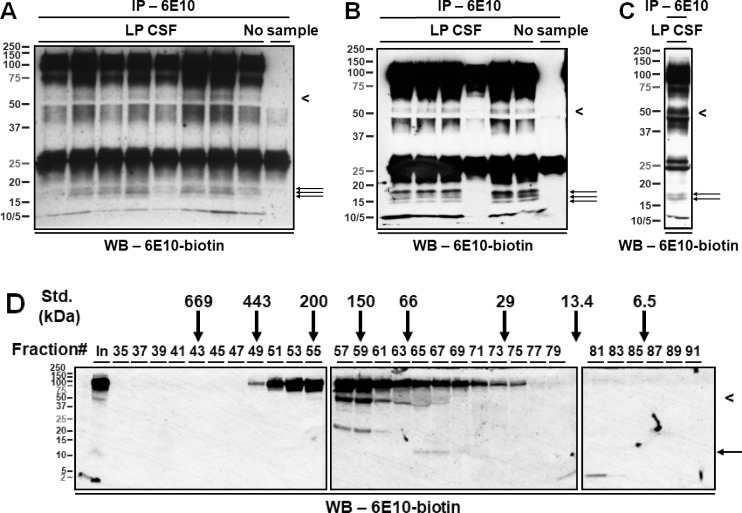
6E10-immunoreactive proteins in human CSF.(A-C) Representative IP/WB. Monoclonal antibody 6E10 was used to immunoprecipitate Aβ/APP metabolites from human CSF samples (250 μL per sample). Immunocaptured proteins were separated by SDS-PAGE, and detected by biotinylated 6E10. Note the proteins migrating at ~55 kDa (arrowhead) and at ~15 kDa (arrows), which are further characterized in this study. Proteins migrating at ~100 kDa and at <10 kDa likely represent the soluble, α-secretase-cleaved APP metabolites (sAPPα) and monomeric canonical Aβ1-40/42, respectively. Proteins migrating at ~70 kDa likely represent APP metabolites whose identities are beyond the scope of investigation of this study. Three sets of samples (A, 250 μL of CSF per lane; B, 240 μL of CSF per lane; C, 160 μL of CSF) were immunoprecipitated by monoclonal antibody 6E10; the eluates were separated by SDS-PAGE using 10.5–14% Tris-HCl gels and detected by biotinylated 6E10. The IP/WB experiments were performed by different experimenters at three different times spanning a five-year period; nonetheless, Fig 2A, 2B and 2C show a similar WB pattern. (D) WB showing fractionation of 6E10-immunoreactive species by SEC. The ~100- and ~70- kDa proteins were eluted together in fractions 49–75, the ~55-kDa proteins in fractions 57–63, the ~15-kDa proteins in fractions 65–69, and the <10-kDa proteins in fractions 79–83. No <10-kDa proteins were detected in the early fractions containing the ~55- and the ~15- kDa species, and no ~55 kDa or ~15 kDa species were detected in the late fractions containing the <10-kDa species. Five percent of the volume of the injected CSF sample is shown in the first lane (In). Vertical arrows indicate the fractions in which globular protein standards of the indicated molecular weights were eluted. The mismatch between the predicted elution fraction and molecular weights estimated by SDS-PAGE suggests that the 6E10-immunoreactive Aβ/APP metabolites do not migrate through the column as globular proteins. LP CSF, CSF obtained by lumbar puncture from living providers.